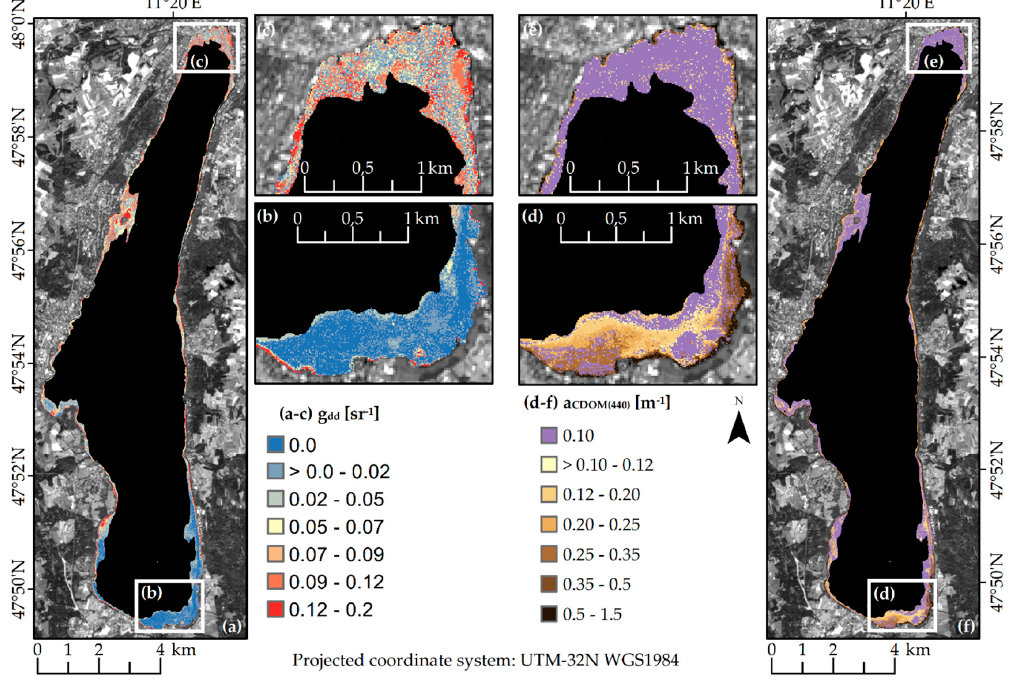
Figure 7. Results of g dd ( a – c ) and a CDOM (440) ( d – f ) of shallow water inversion using the MIP 10 m pixel size dataset. Background is gray scaled S2-A band B05 (705 nm).